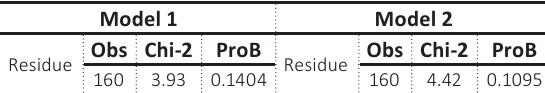
Table 8. Skewness and kurtosis test result